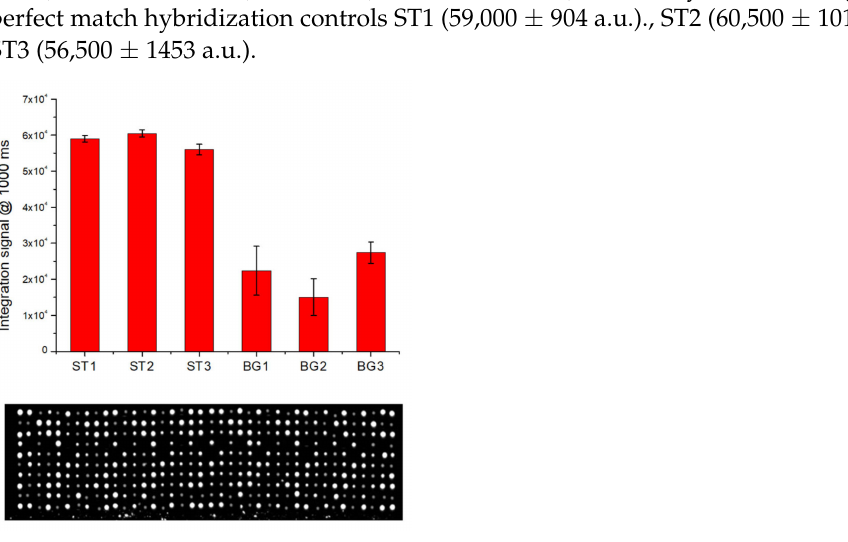
Figure 6. Integrated experiment for the detection of BG on whole human blood by LoC-MA: fluores- cence signal (1000 ms) for the hybridized spot ( top ) and representative fluorescence image ( bottom